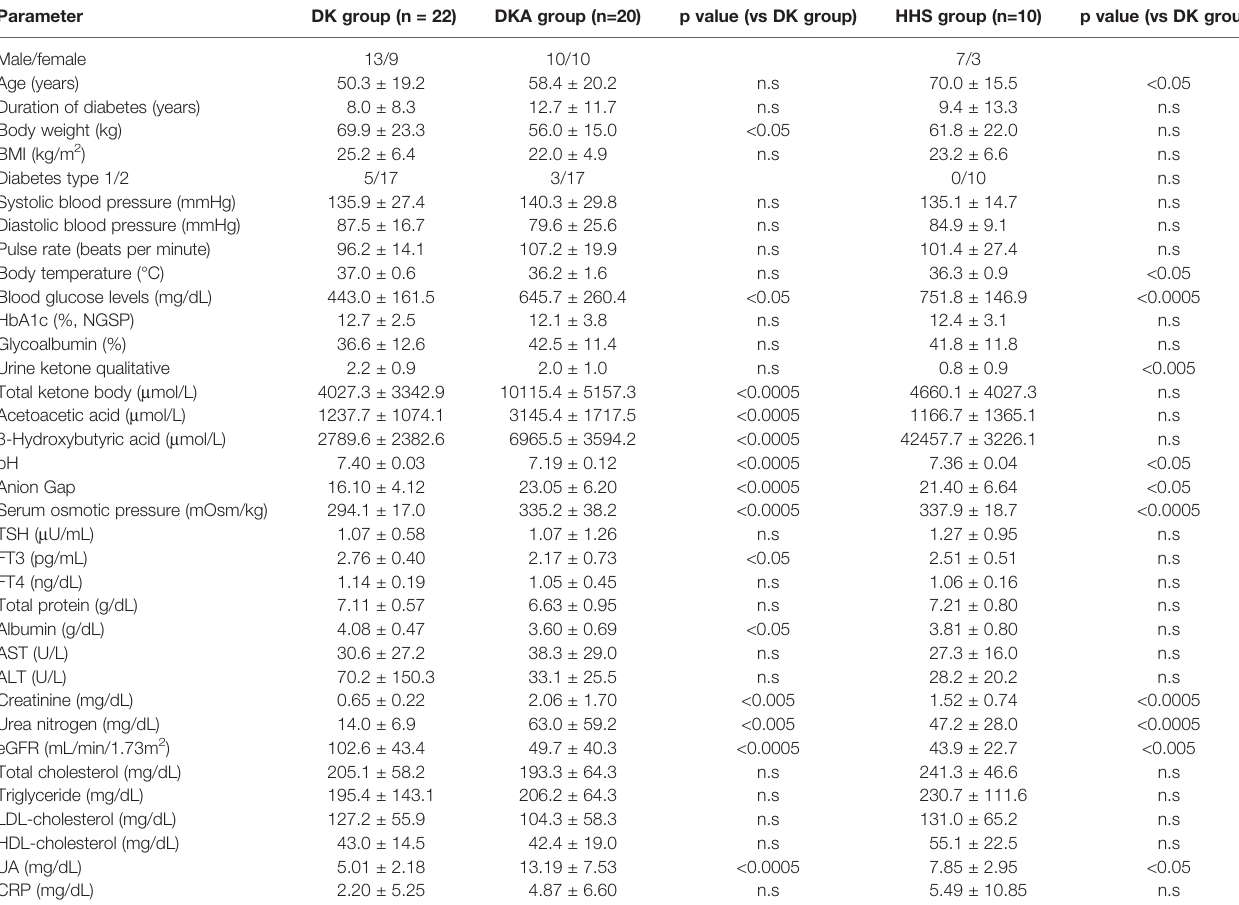
TABLE 1 | Comparison of various values among DK, DKA and HHS group on admission.